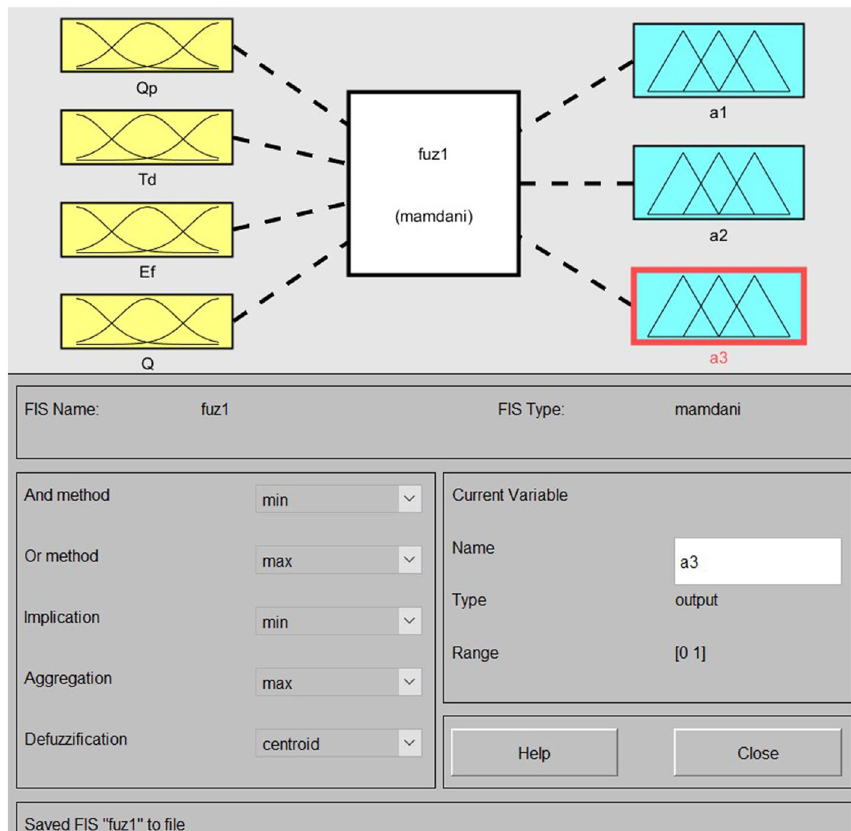
Fig. 2 Fuzzy logic converts PMS input parameters into three output-weighing